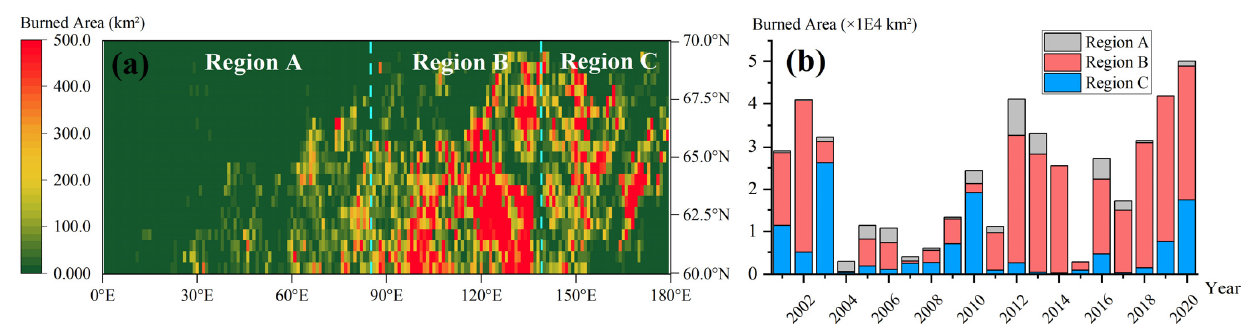
Figure 9. Spatial and temporal distribution of burnt area. The spatial distribution of burnt area over 20 years is shown in ( a ). The temporal distribution of burnt area in three regions and their contribution to the total burnt area in the whole Eurasian Arctic is shown in ( b ). Table 2. 20-year total burnt area for each of the five main land-cover types. The other land-cover classes include non-vegetated classes of urban areas, bare areas, and areas labeled as water bodies. “Type/A (%)” represents the area burnt for each land-cover type as a proportion of the area of region A. “A/ALL (%)” represents, for the total burnt area of the specified land-cover type, the proportion contributed by region A.